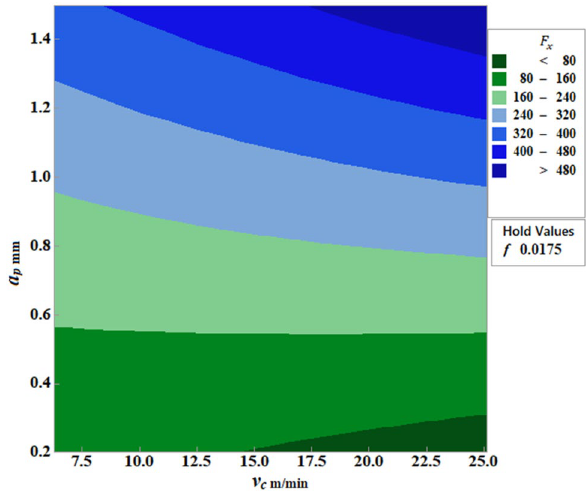
Fig. 6 Cutting force F x vs a